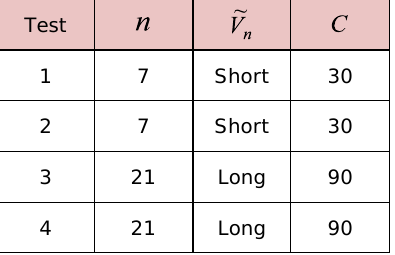
Table 1. “Simulation